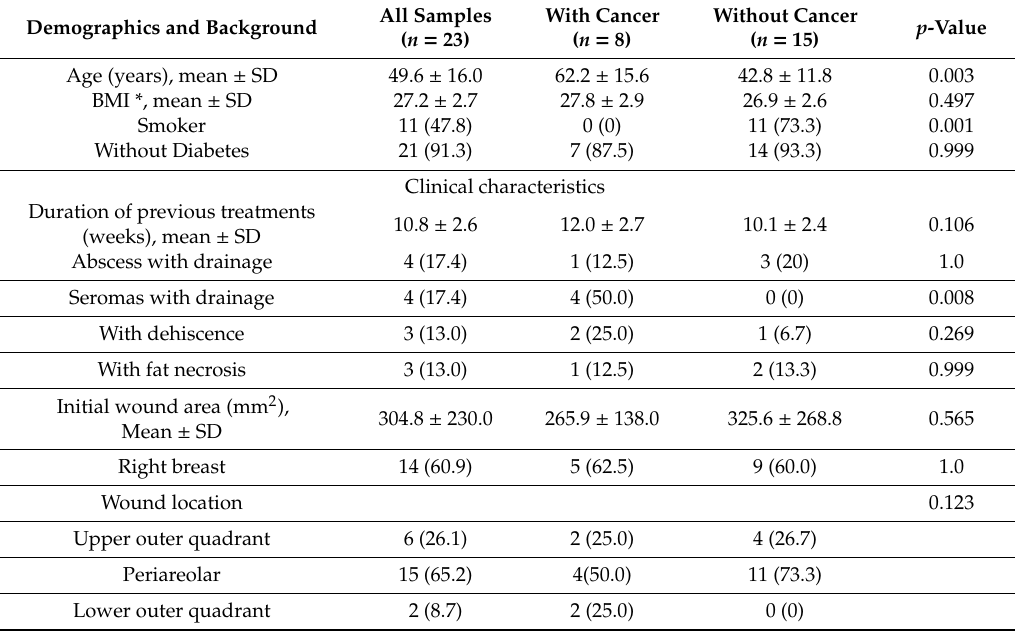
Table 1. Characteristics of all participants and patients with a history of breast cancer and patients without breast cancer.